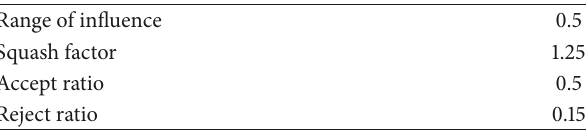
Table 5: Parameters of the hybrid method